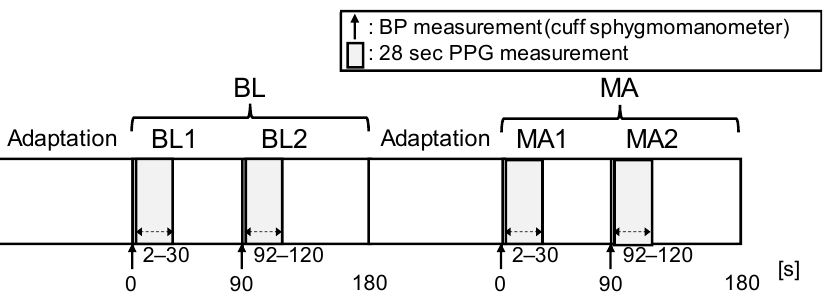
Figure 4. Experimental protocol. The experiment consisted of 2 periods: baseline (BL) and mental arithmetic (MA). Each period lasted 180 s. A total of 2 BP measurements and a PPG measurement (28 s) were taken for each period. The BL period measured the resting condition, and the MA period measured the stress condition induced via mental arithmetic.